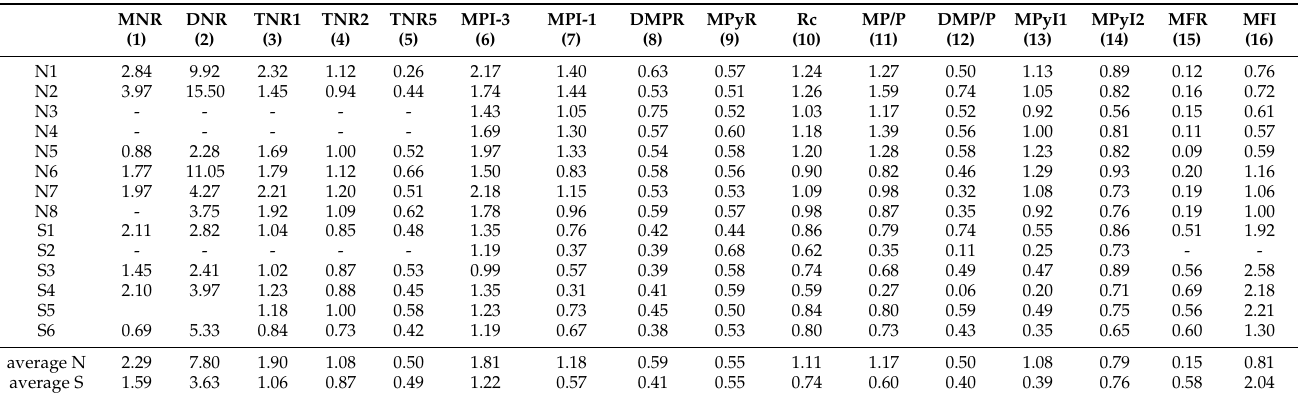
(Table 5). As Figures 15 and 16 show, there are distinctive differences between both sets in the relative contents of alkyl naphthalene and phenanthrene isomers used in calculating these ratios. Since these ratios are built based on variability in isomer resistance to increas- ing temperature, the ratio values will increase with increasing heat, due to the thermal evolution of organic matter in a deposit, or due to magmatic intrusion or internal fire [78]. According to the Shapiro–Wilk test, the values of aromatic hydrocarbon ratios showed normal distribution, except the MFR values set. Thus, the Pearson correlation has been applied to calculate the square of the Pearson product moment correlation to find whether there is a linear correlation between selected ratios. Linear correlations between various aromatic hydrocarbon maturity ratios confirm that both sample sets were initially of the same maturity and similar in type of organic matter. Correlation coefficient values of 0.3376– 0.4664 indicate weak correlations for DMPR versus MPI-1, MPI-3 and MP/P and values of 0.6040–0.7350, moderate to strong positive correlations for MPy-1 versus MPI-1, MPI-3 and MP/P (Figure 17). Negative correlations (from –0.6059 to –0.8079) between MFR and MPI-1, MPI-3 and MP/P reflect the fact that the MFR decreases with increasing maturity. In Figure 17, values for the red and grey samples show minimal overlap. The higher maturity of the grey rocks is indicated. Aromatic hydrocarbon maturity ratios appear to be more sensitive than biomarker ratios to short-term thermal influences; unlike the former, pentacyclic triterpene and sterane ratios do not show significant differences. In organic matter, the biomarker ratios preserve initial geochemical features due to earlier catagenesis and mild long-term heating. Except for Ts and Tm, they did not register later higher-temperature thermal stresses of short duration. Thus, the aliphatic biomarkers and alkyl aromatic hydrocarbons enable discrimination between earlier catagenic stages of organic-matter evolution and local changes due to any later intra-deposit heating. Table 5. Aromatic hydrocarbons ratios indicative of